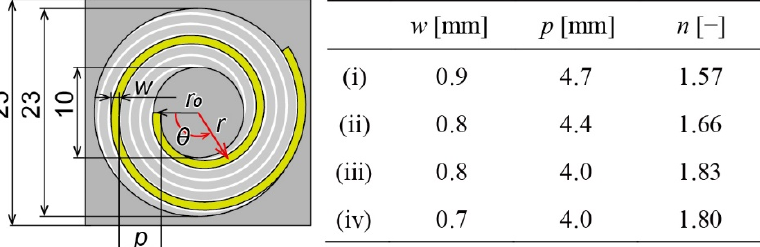
Figure 1. Schematics of the device’s in ( a ) bird’s-eye view and ( b ) side view. The design details of the spiral-coil spring are shown in Figure 2. The overall dimen- sions were 25 × 25 mm, and the central plate was circular with a diameter of 10 mm. The spiral coil had the same shape as the Archimedes spiral. The four coils were equally spaced with a phase difference of 90 ◦ and did not interfere with each other. The longer the length of the spiral, the smaller the spring constant.